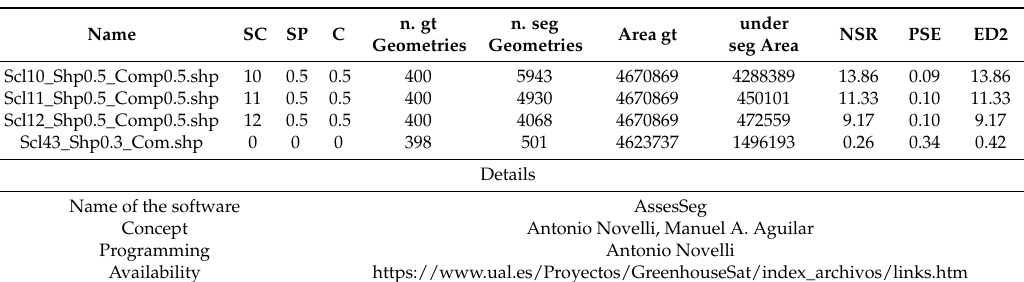
Table A1. AssesSeg output table example. From left to right are enumerated the following columns: name, scale parameter (SC, for MRS outputs), shape parameter (SP, for MRS outputs), compactness parameter (C, for MRS outputs), number (n) of ground truth (gt) geometries, number of segmented (seg) geometries, area gt (total area of gt geometries), under seg area (total under segmented area), number-of-segments ratio (NSR, modified or original), potential segmentation error (PSE, modified or original), and Euclidean Distance 2 (ED2, modified or